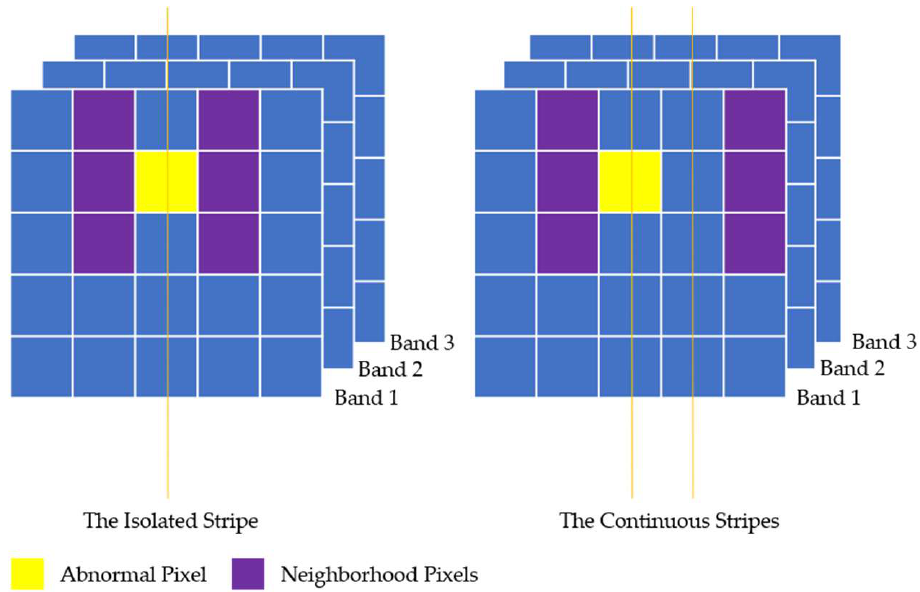
Figure 8. Abnormal pixel restoration schematic diagram. The yellow pixel represents the abnormal pixel, the purple pixel stands for the neighborhood pixel, and the blue pixel denotes unselected pixel in this restoration.